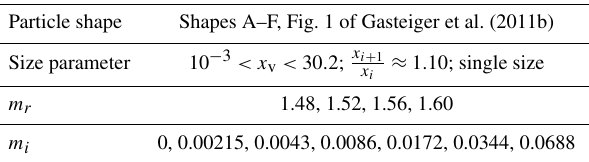
Table 2. Microphysics of irregularly shaped particles considered in the MOPSMAP data